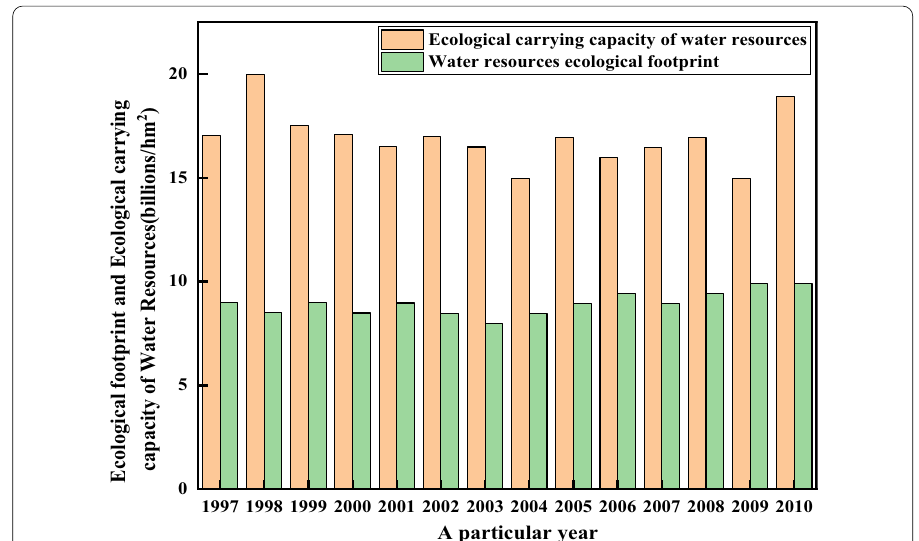
Fig. 4 Ecological footprint and ecological carrying capacity of water resources in China 1997–2010